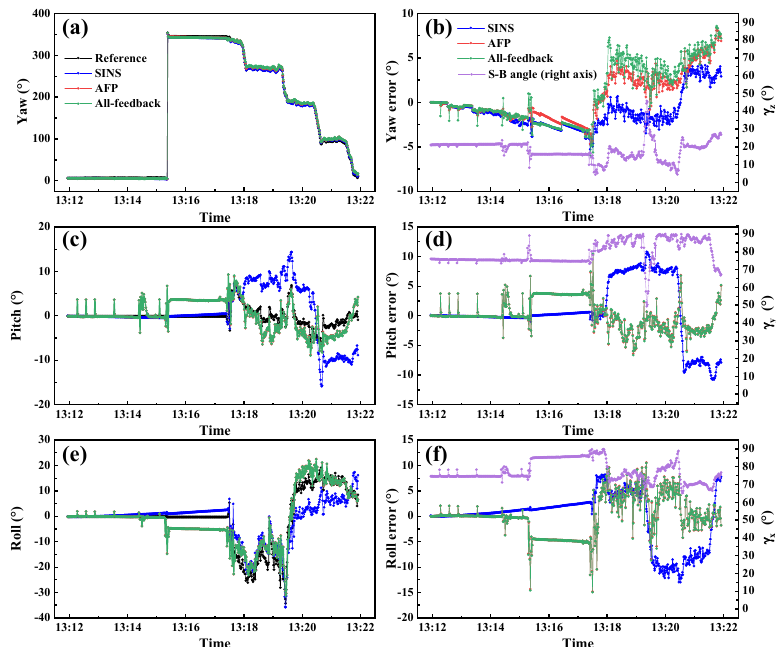
Figure 14. Attitude angle estimation and error curves of real-world experiment. Table 7. Attitude estimation error statistics of real-world experiment.